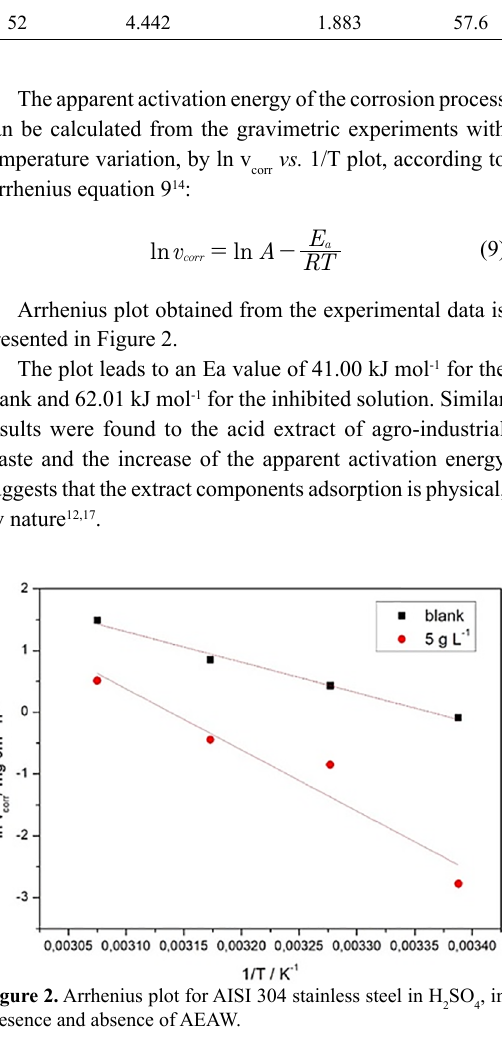
Figure 2. Arrhenius plot for AISI 304 stainless steel in H presence and absence of